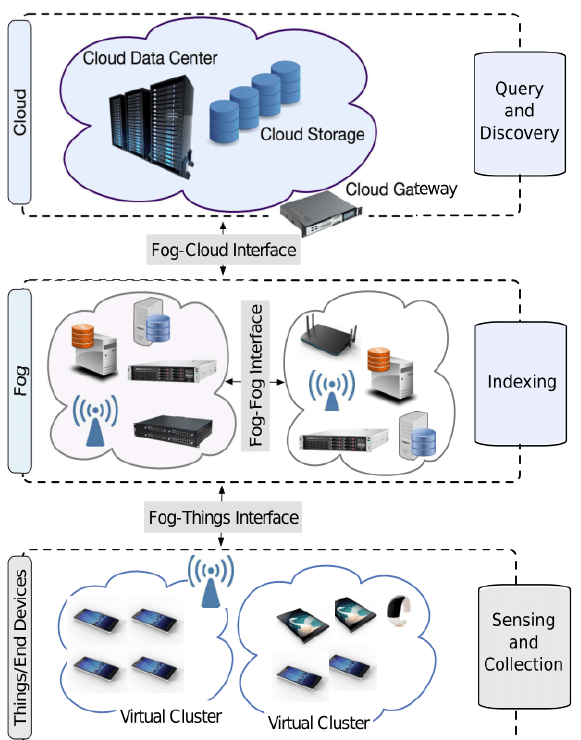
Figure 1. Discoverable and searchable of Big IoT Data indexing from different IoT devices under three-tier fog computing